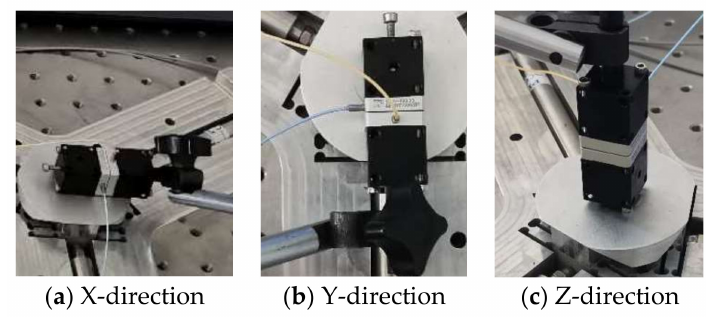
Figure 7. Micro-positioning platform test system.